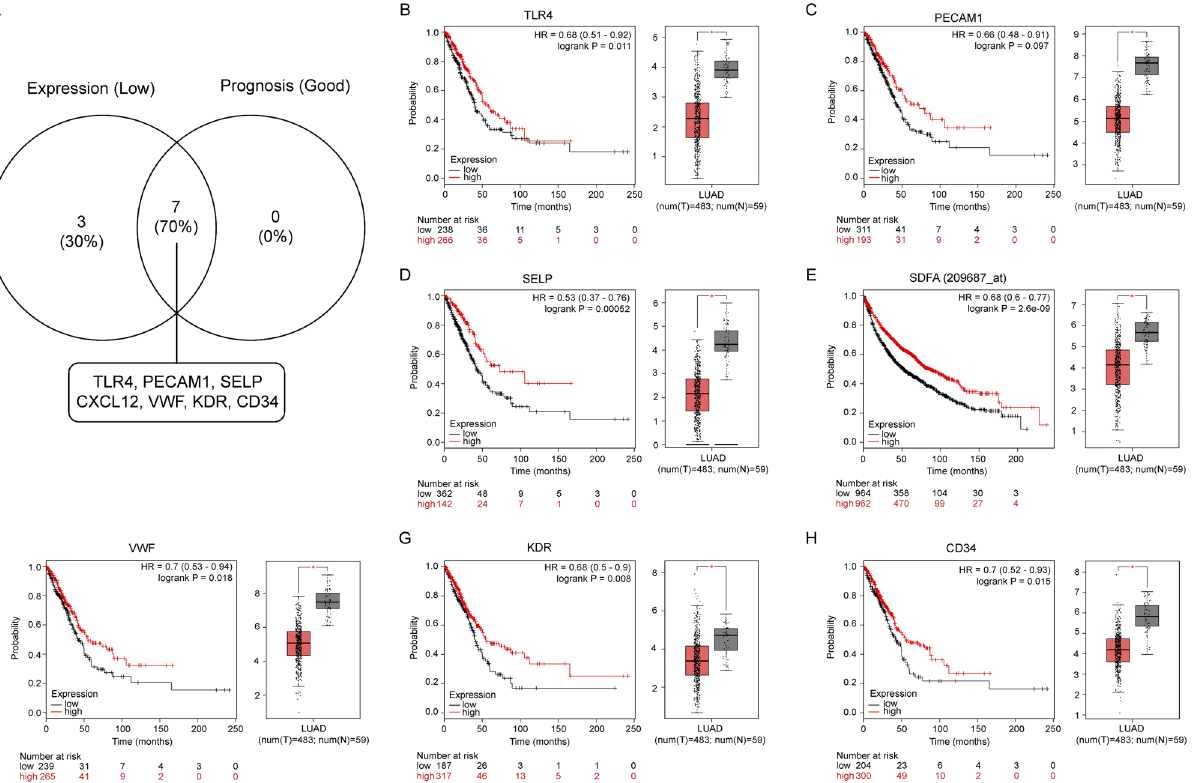
Figure 4. Screening the key downregulated genes in LUAD. ( A ) Identification of key genes with low expression and good prognosis values in significantly downregulated hub genes. ( B – H ) Representative expression and prognostic value of hub genes validated with GEPIA and Kaplan–Meier plotter databases, respectively.